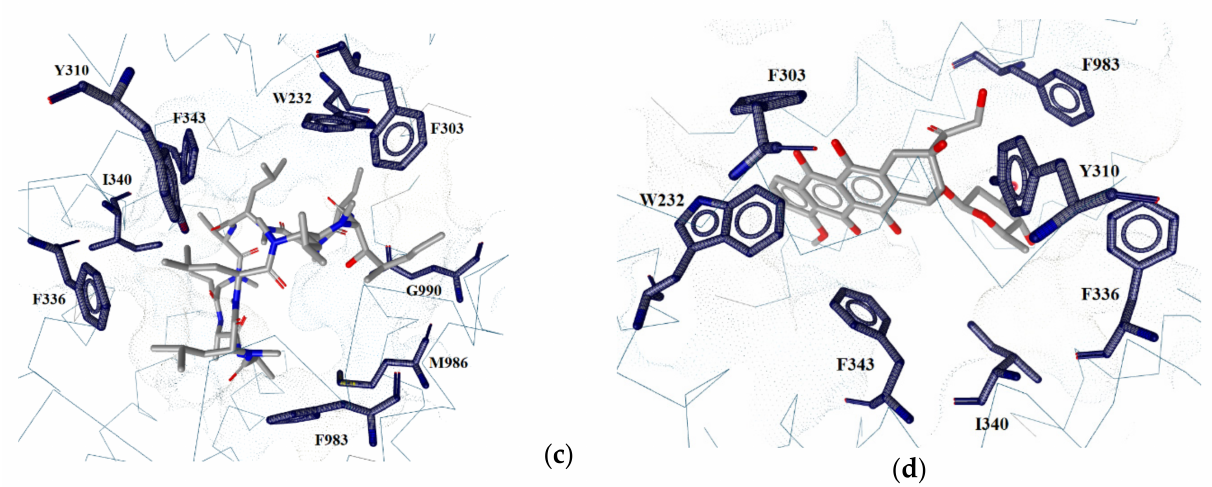
Figure 5. Simultaneous interactions detected in the active compounds: ( a ) amiodarone, ( b ) carvedilol, ( c ) cyclosporine A, ( d ) doxorubicin.